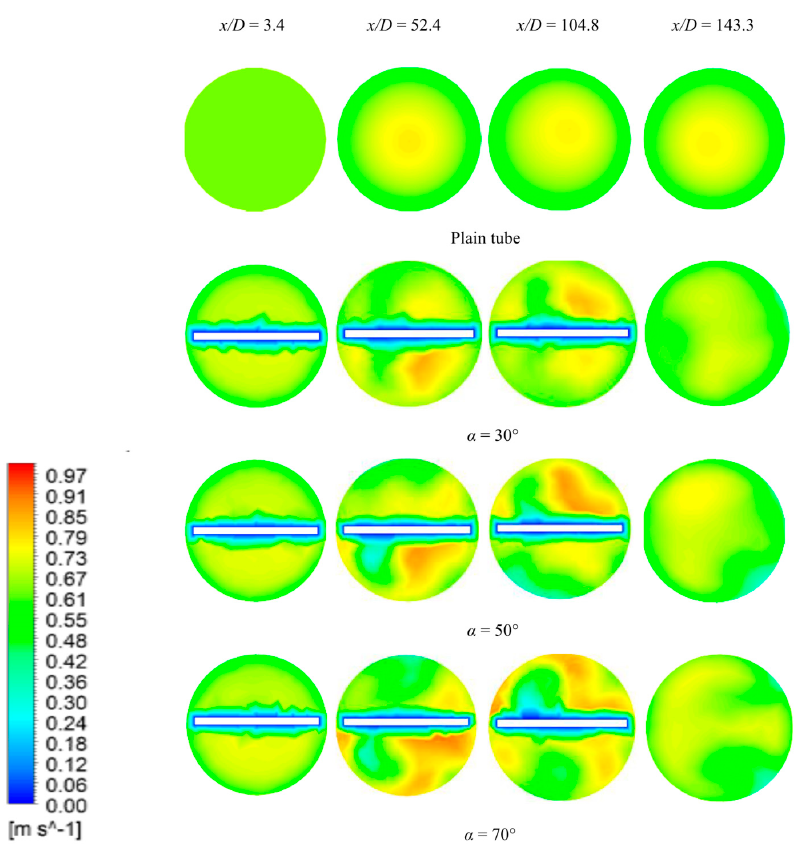
Figure 9. Velocity contour at Re of 17,400.